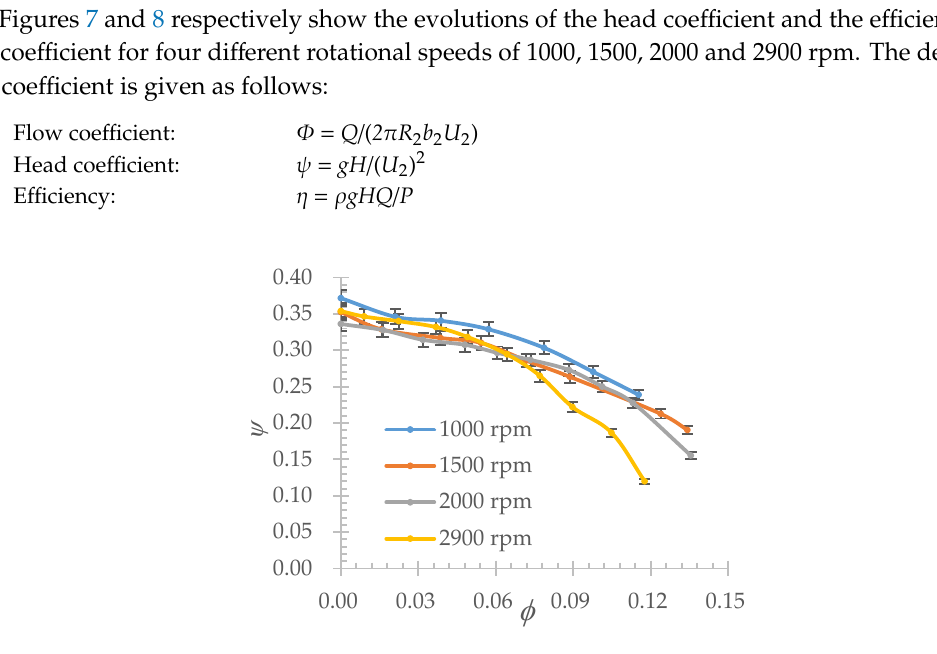
Figure 7. Head coefficient versus flow coefficient for several rotational speeds.